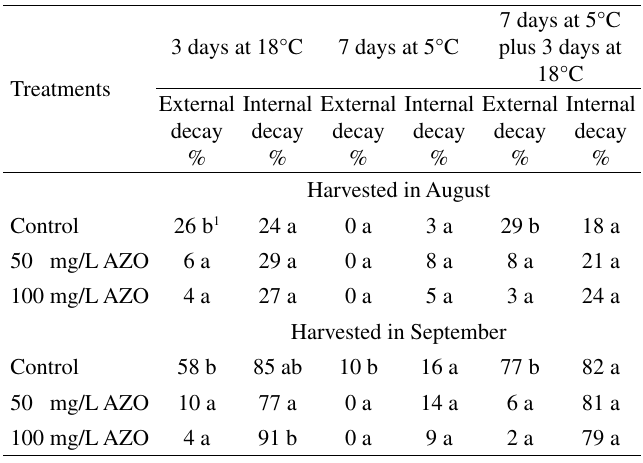
ing to Fisher’s test of the least significant